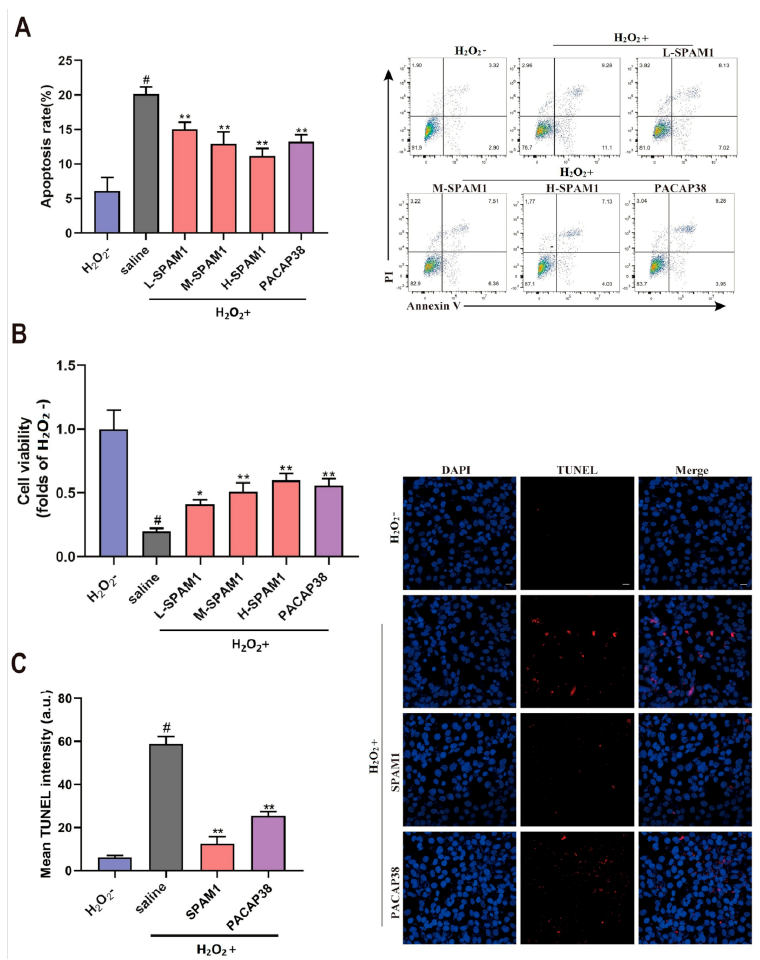
Figure 3. The cytoprotective activity of SPAM1. ( A ) The data analysis ( left ) of Annexin V-FITC/PI double staining and flow cytometry ( right ) showed that SPAM1(0.01–1 µ M) and PACAP38(1 nM) significantly inhibited apoptosis induced by H 2 O 2 ; ( B ) CCK8 results confirmed that SPAM1(0.01– 1 µ M) and PACAP38(1 nM) significantly increased cell viability that decreased by H 2 O 2 ; ( C ) effect of SPAM1 and PACAP38 on apoptosis determined by TUNEL assay and corresponding analysis ( left ) of the TUNEL images ( right ) in RGC-5 cells induced by H 2 O 2 . It was shown that SPAM1(0.01–1 µ M) and PACAP38(1 nM) has significantly cytoprotective activity against the apoptosis induced byH 2 O 2 . #, p < 0.05, H 2 O 2 + group vs. H 2 O 2 − group; *, p < 0.05, vs. H 2 O 2 + group; **, p < 0.01, vs. H 2 O 2 + group. Data are presented as the mean ± SEM of three experiments (Scale bars: 20 µ